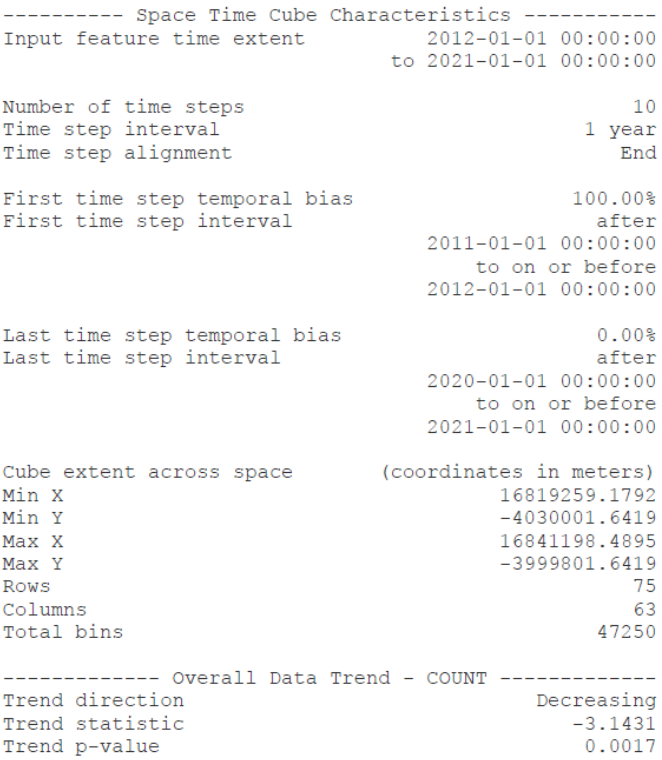
Figure A1. Club licence space-time cube logfile.